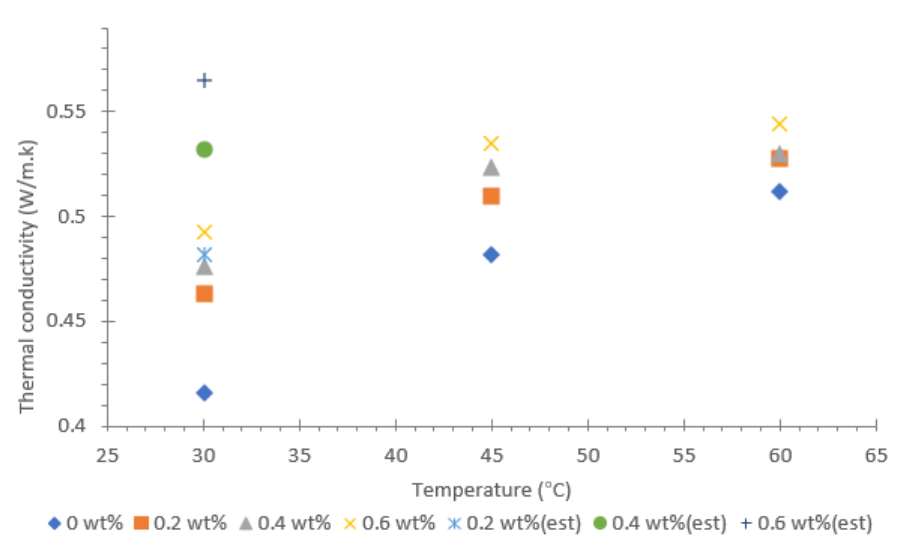
Figure 6. Thermal conductivity of soybean oil/Al 2 O 3 -TiO 2 hybrid nanofluid.